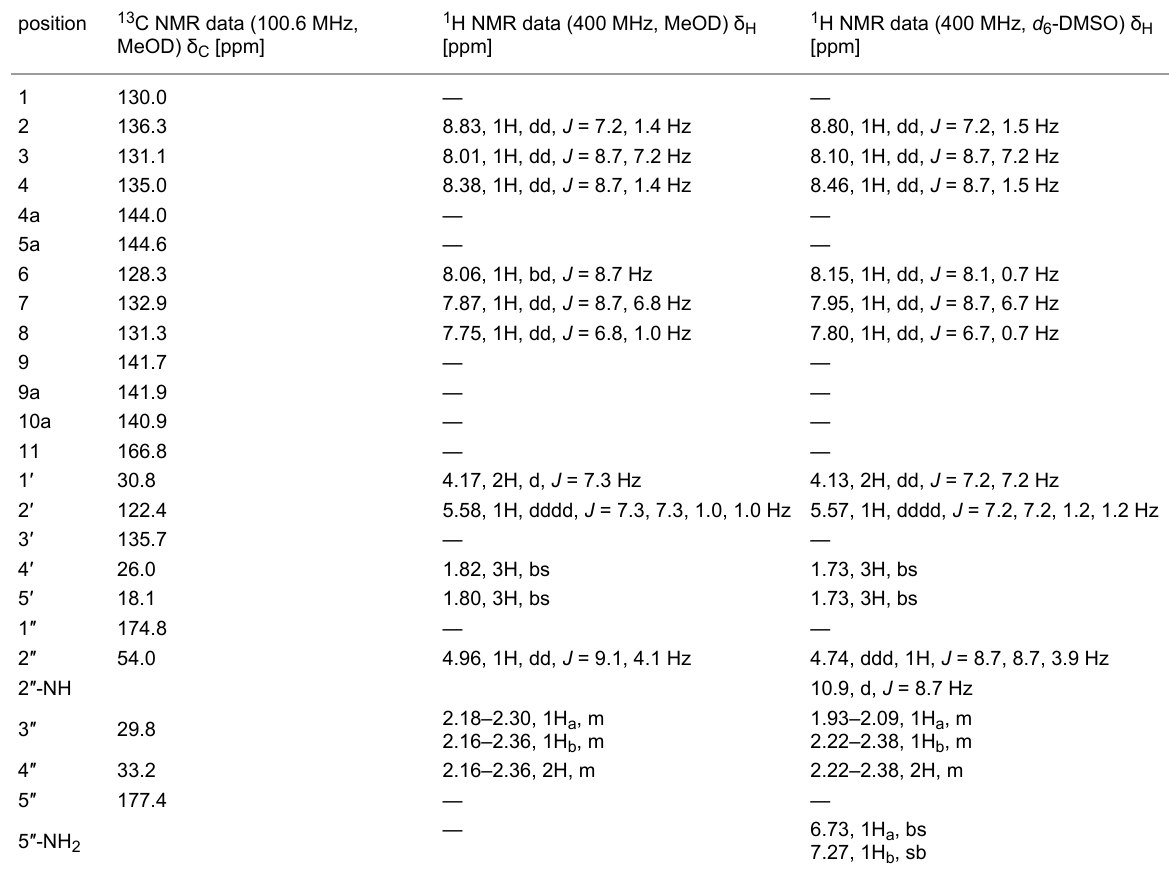
Table 2: Full 1 H and 13 C NMR spectroscopic data of endophenazine E. Chemical shifts are expressed in δ values with the solvent as the internal standard.